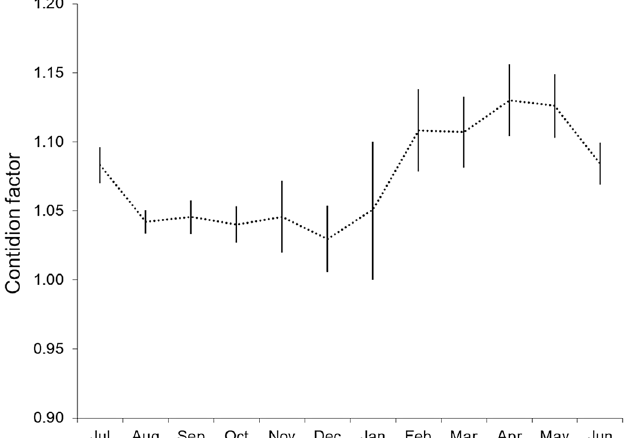
Fig. 10. Monthly average of condition factor for pooled sexes of Pagrus pagrus between 270 and 450mm TL ( n = 2495) fi shed along southern Brazil. Vertical bar represents 95% con fi dence